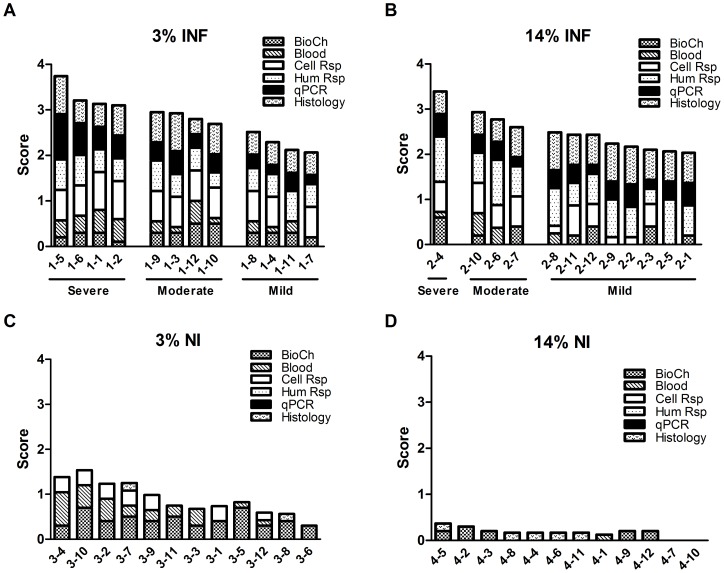
Disease score for visceral leishmaniasis.A score to measure the grade of severity of the disease was performed for 3%INF (A), 14%INF (B), 3%NI (C) and 14%NI (D). For each hamster, a score of 2 was given to values below normal for leukocytes, lymphocytes, PLT and albumin; and to values above normal for total proteins, BUN, AST, globulin and erythrocytes. Other abnormalities in these biochemical (BioCh) or blood variables were scored as 1. Lymphoproliferative responses for SLA and CONA were scored as: 3 for a stimulation index (SI) <0.60; 2 for 0.60≤ SI<2.00; 1 for 2.00≤ SI<4.00; and 0 for SI≥4.00. The humoral response as determined by ELISA was scored as: 1 for 0.10≤ OD 430 nm <0.60; 2 for 0.60≤ OD 430 nm <1.00; 3 for OD 430 nm≥1.00. As determined by IFAT, the humoral response was scored as: 1 for 1/80 titre; 2 for 1/160 titre; 3 for 1/320 titre. Spleen and bone marrow parasite loads as determined by qPCR were scored as: 1 for 35≤ parasites/μg/ml<1000; 2 for 1000≤ parasites/μg/ml<5000; 3 for parasites/μg/ml≥5000. Liver and lymph node parasite loads were scored as: 1 for 35≤ parasites/μg/ml<600; 2 for parasites/μg/ml≥600. Presence of Leishmania DNA in the blood was given a disease score of 2. Histopathology for liver and spleen was scored from 0 to 3. A corrective factor was applied to the 6 categories of data to compensate the global score. Visceral leishmaniasis status was recorded as: Mild, when the total score for an animal was 2–2.5; Moderate, when between 2.6–3.0; and Severe, when >3.1. The bars represented each hamster and showed the contribution of each parameter to the total score. Abbreviations: BioCh- serum biochemistry profile, Blood- haematological alterations, Cell Rsp- lymphoproliferative response to SLA and CONA, Hum Rsp- ELISA and IFAT results, qPCR- parasite load (blood, lymph node, spleen, liver and bone marrow), and Histology- grade of alterations in spleen and liver.